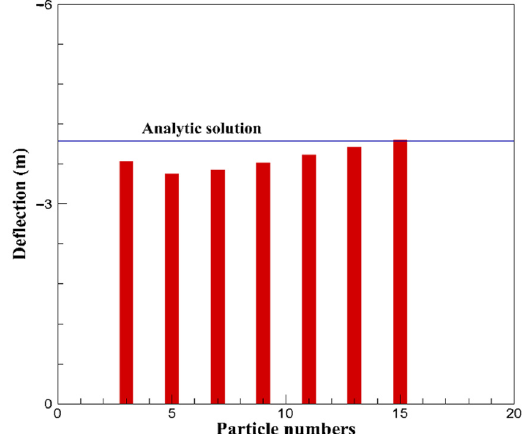
Figure 5. Cantilever beam deflection for various particle numbers.